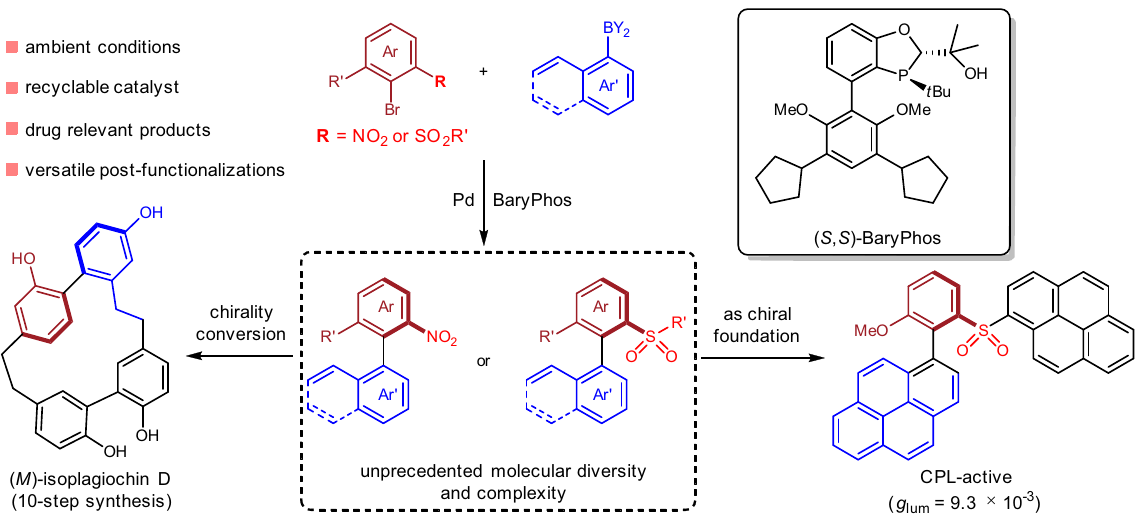
Fig.1| ortho S-orN-substitutedaxiallychiralbiaryls.a Theprevalenceof ortho S- or N-substituted axially chiral biaryls and relavent achiral aryl sulfonyl-containing drugs. b Limited accessibility of chiral biaryls with ortho functionalities by